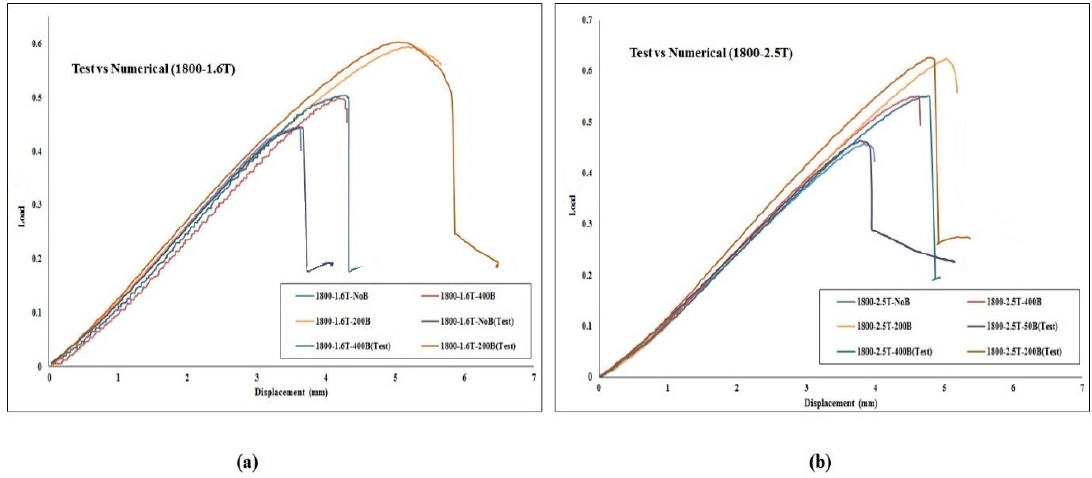
Figure 10. Comparison of experimental and numerical results of normalised load for ( a ) 2400L-1.6T, ( b ) 2400L-2.5T.